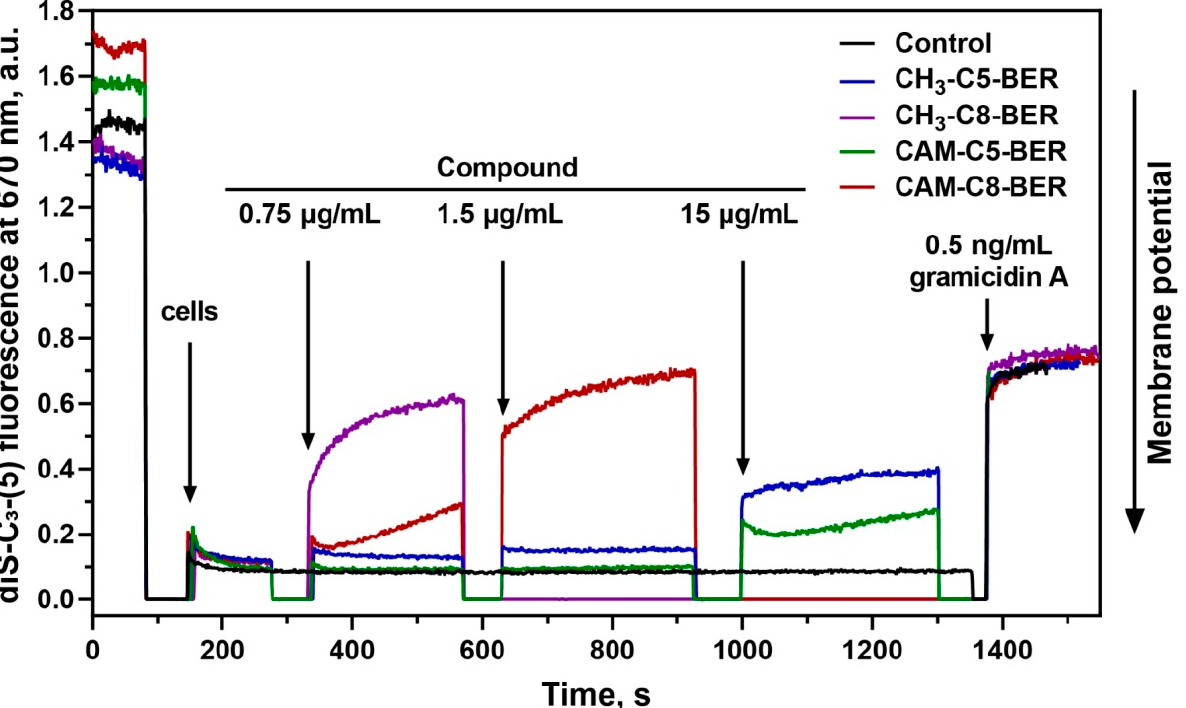
Figure 5. Effect of CAM-Cn-BER (n = 5, 8) and CH 3 -Cn-BER (n = 5, 8) on the kinetics of the membrane potential of B. subtilis cells measured using the fluorescent probe diS-C 3 -(5). Arrows mark moments at which appropriate amounts of the compounds were added. Gramicidin A at a concentration of 0.5 ng/mL was used as a control.